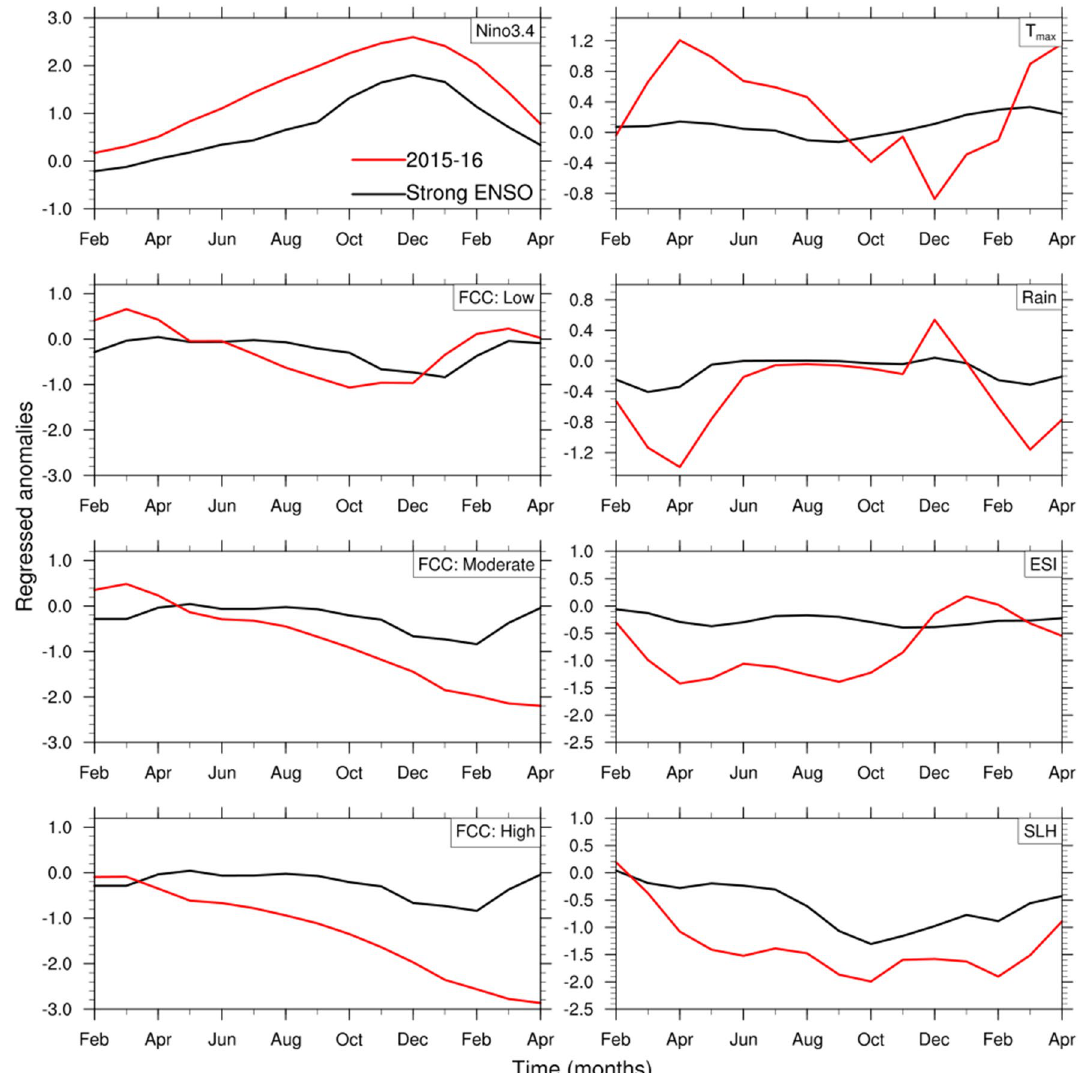
Figure 2. Monthly evolution of Niño3.4, mangrove FCC for 3 dieback categories, T max , rainfall, ESI, and sea level height (SLH) anomalies during previous strong El Niño conditions (black curve) and 2015–2016 (red). All the variables are normalized by their own standard deviation before lag-regressing the normalized anomalies onto Niño3.4 and the regression coefficients are scaled by normalized Niño3.4 index magnitude during strong ENSO. Plots are generated using the NCAR Command Language version 6.6.2 (http:// www. ncl. ucar.